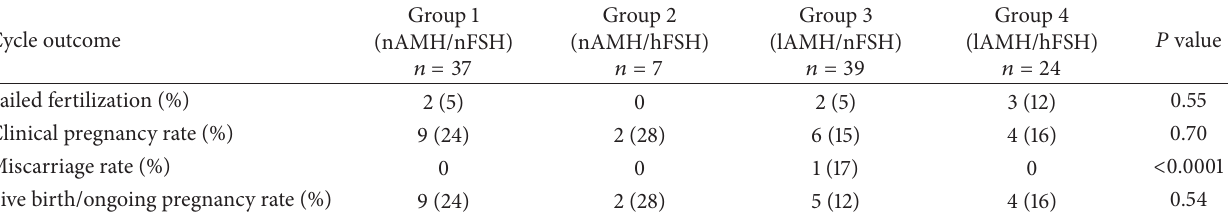
Table 2: Comparison of failed fertilization, clinical pregnancy, miscarriage, and live birth/ongoing pregnancy rates. Cycle